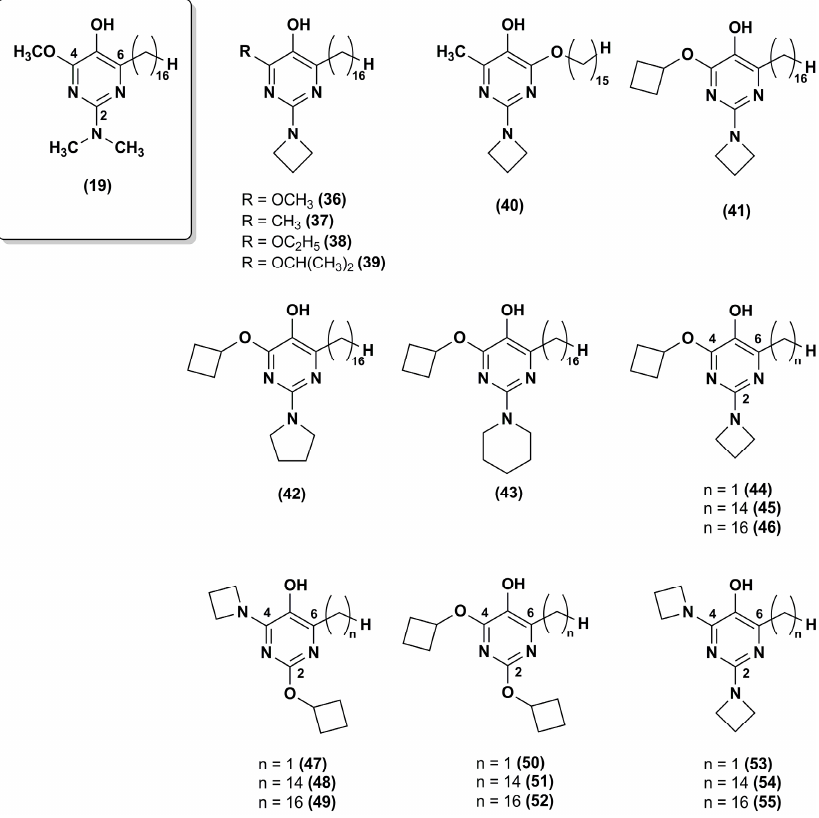
Figure 7. Chemical structures of compound 19 analogues.